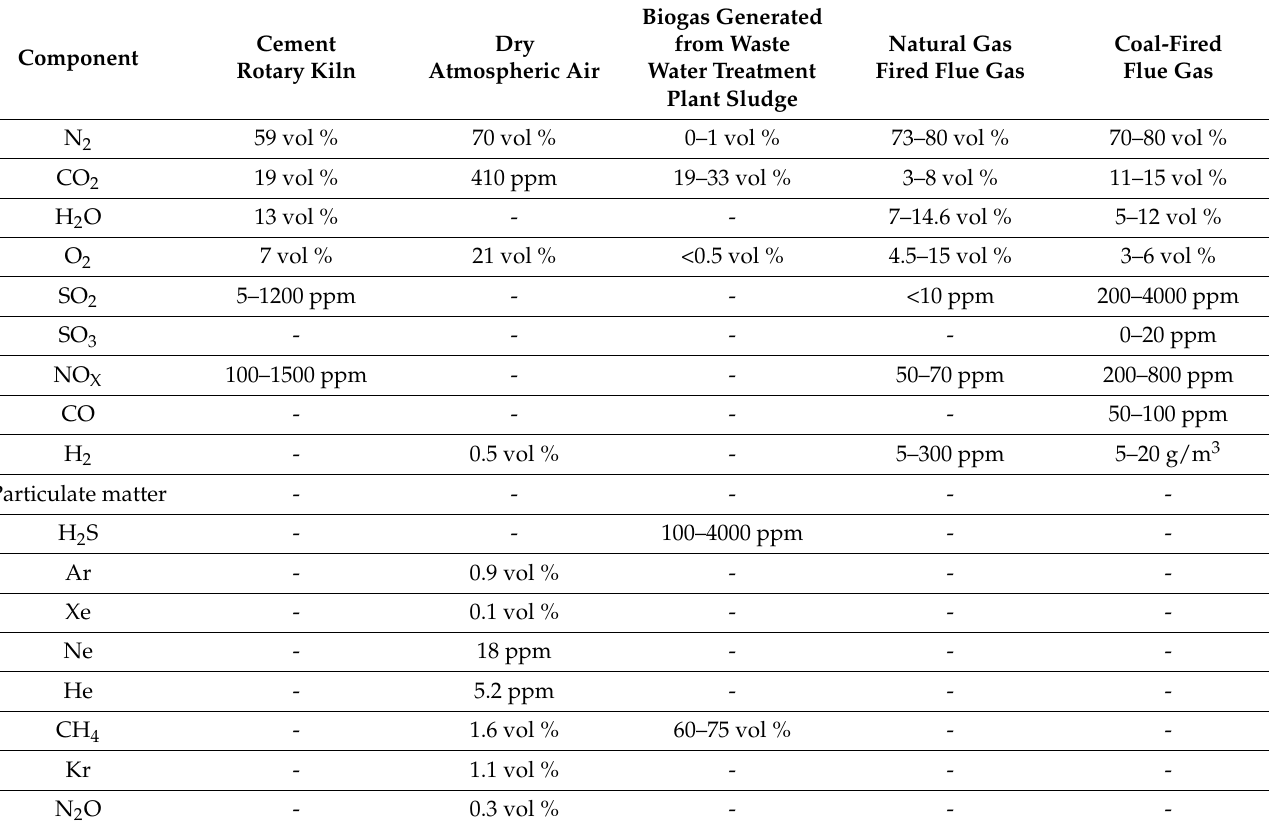
Table 1. Compositions of different gas streams which act as potential CO 2 capture opportunities (Reprinted with permission from ref.